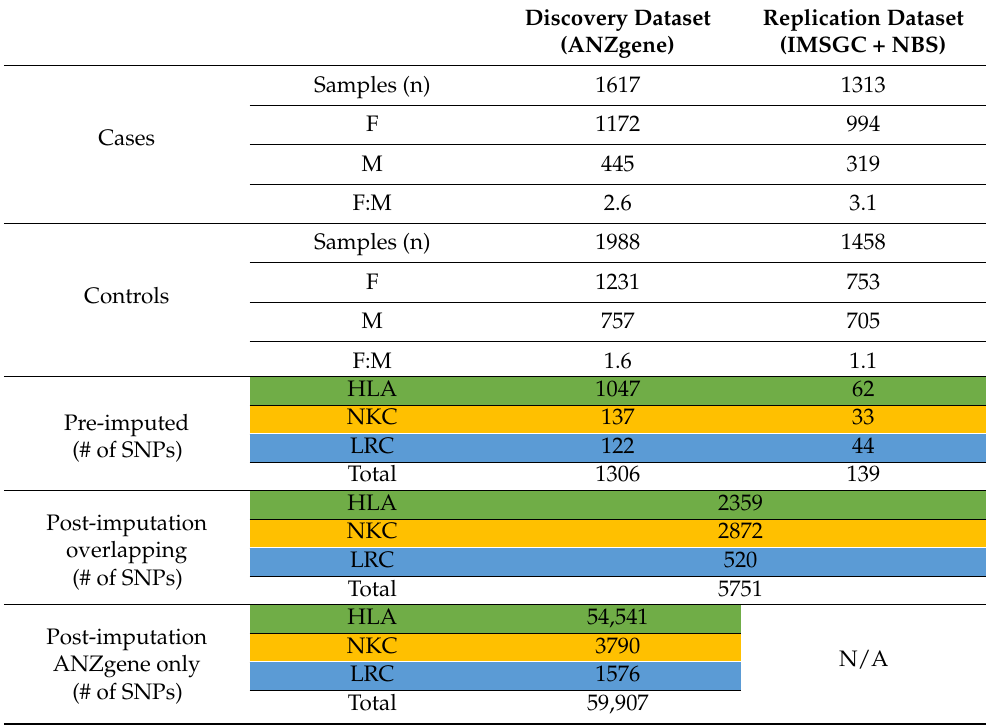
Table 1. Cohort summary information for the discovery (ANZgene) and the replication dataset (merged from two IMSGC GWAS and the national blood service as controls. The number of SNPs passing QC is given for each of the three loci, human leukocyte antigen complex (HLA) (green), natural killer cell complex (NKC) (orange) and leukocyte receptor complex (LRC) (blue) from chro- mosomes 6, 12 and 19, respectively. The number of SNPs is provided for both cohorts, pre-imputation and restricted to common SNPs post- imputation (with a high imputation quality threshold of R 2 = 0.8). Independent post-imputation analysis was restricted to the discovery cohort (ANZgene) due to the increased number of SNPs available pre-imputation compared to the merged replication dataset, resulting in a much greater yield of high-quality imputed SNPs (R 2 = 0.8). Discovery Dataset Replication Dataset (ANZgene) (IMSGC + NBS) Samples (n) 1617 1313 F Cases